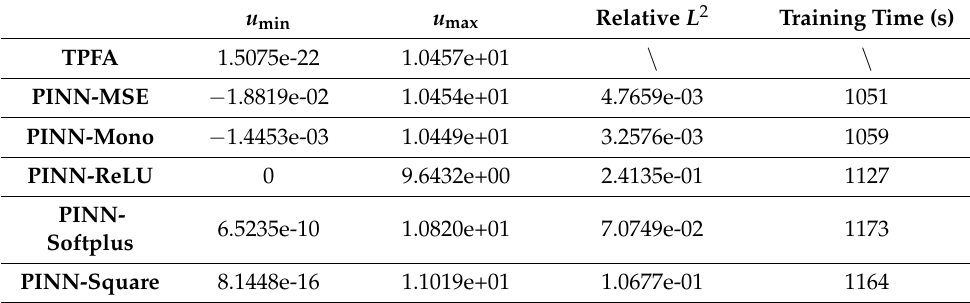
Figure 5. PINN solutions for case 1: θ = 0. The first row corresponds to the results of the PINN-MSE model and the second row the PINN-Mono model. Table 1. Summary of computational results for case 1: θ =